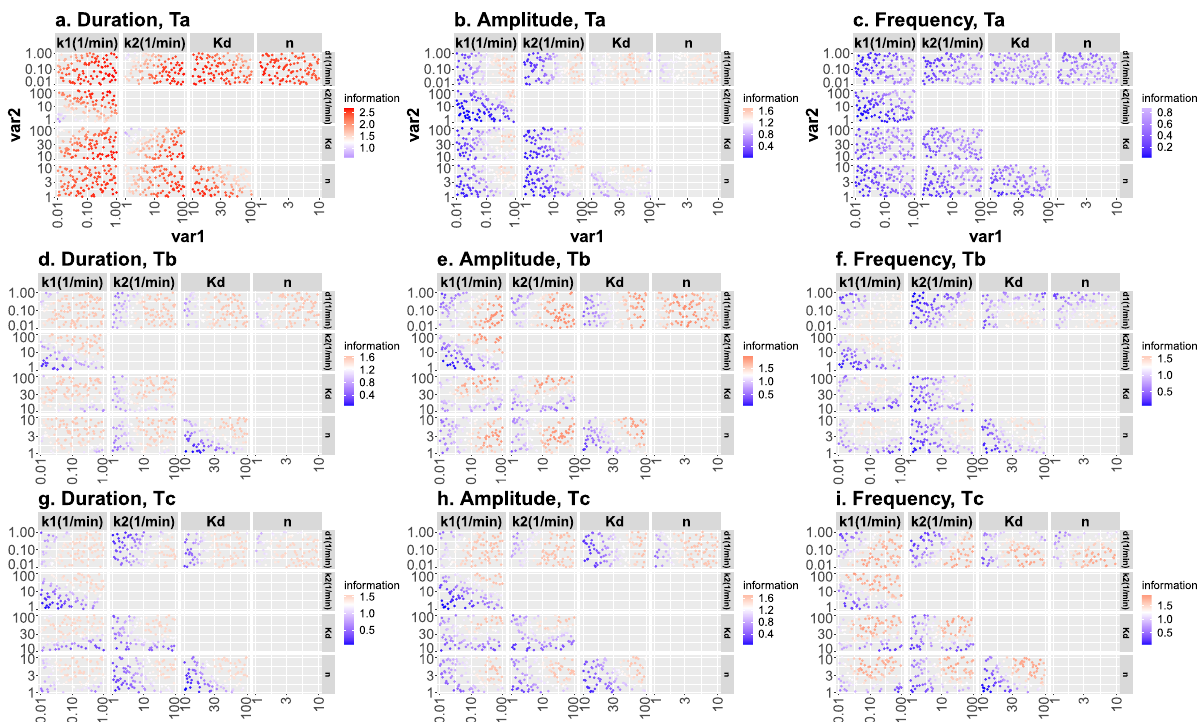
Figure 4. Mutual information, MI , as a function of two parameters while the others are left fixed at the values that maximize MI for the particular input and output types analyzed in each case ( a – c , d – f , g – i correspond, respectively, to the T a , T b and T c output time cuts; a – d – g , b – e – h , c – f – i correspond, respectively, to duration, amplitude and frequency input modulation type). Common behaviors are observed throughout most modulations and time